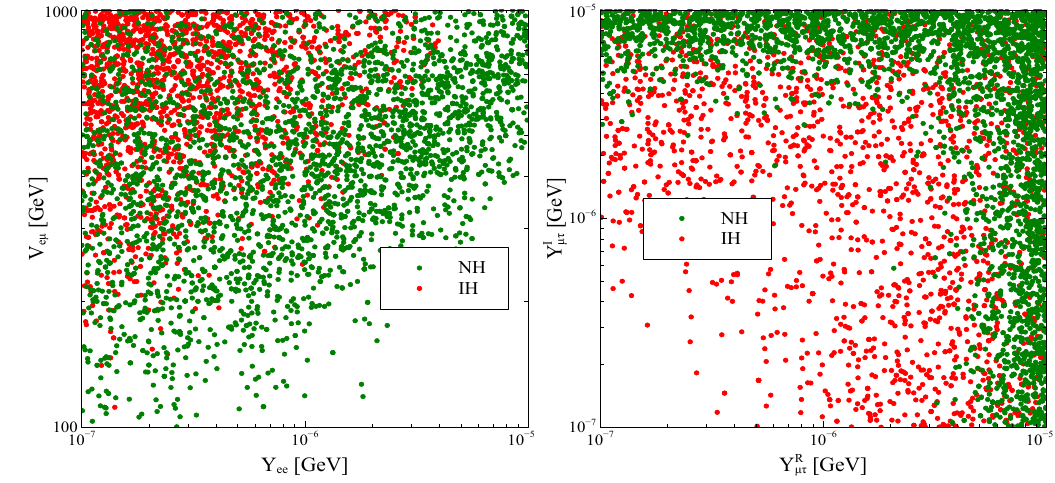
Figure 5 . Each point satis(cid:12)es neutrino oscillation data and here also we (cid:12)nd overlapping regions between NH and IH for the elements of (cid:22) matrix.